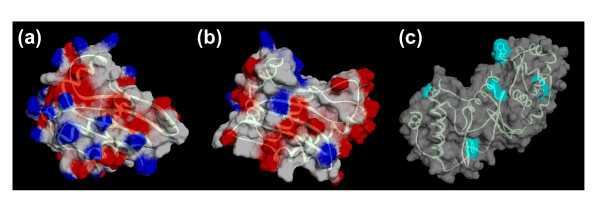
Surface adaptation in hyperthermophiles. Numerous surface acidic residues (red) in both hyperthermophile, (a) 1oz9, and mesophile, (b) 1xax, members of a homologue pair, are joined by many more basic residues (blue) in the hyperthermophile representative. (c) The location of tryptophan residues (cyan) in a hyperthermophile protein (pdb id 1zar).